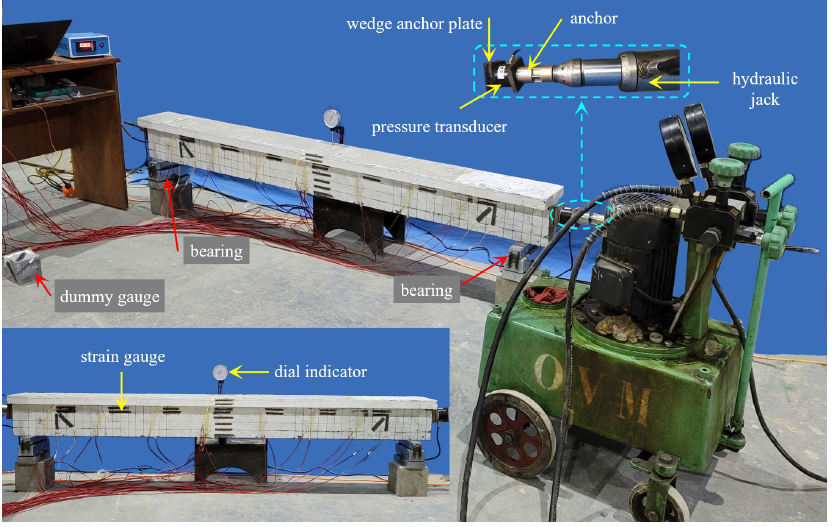
Figure 6. Schematic diagram of prestress tensioning.